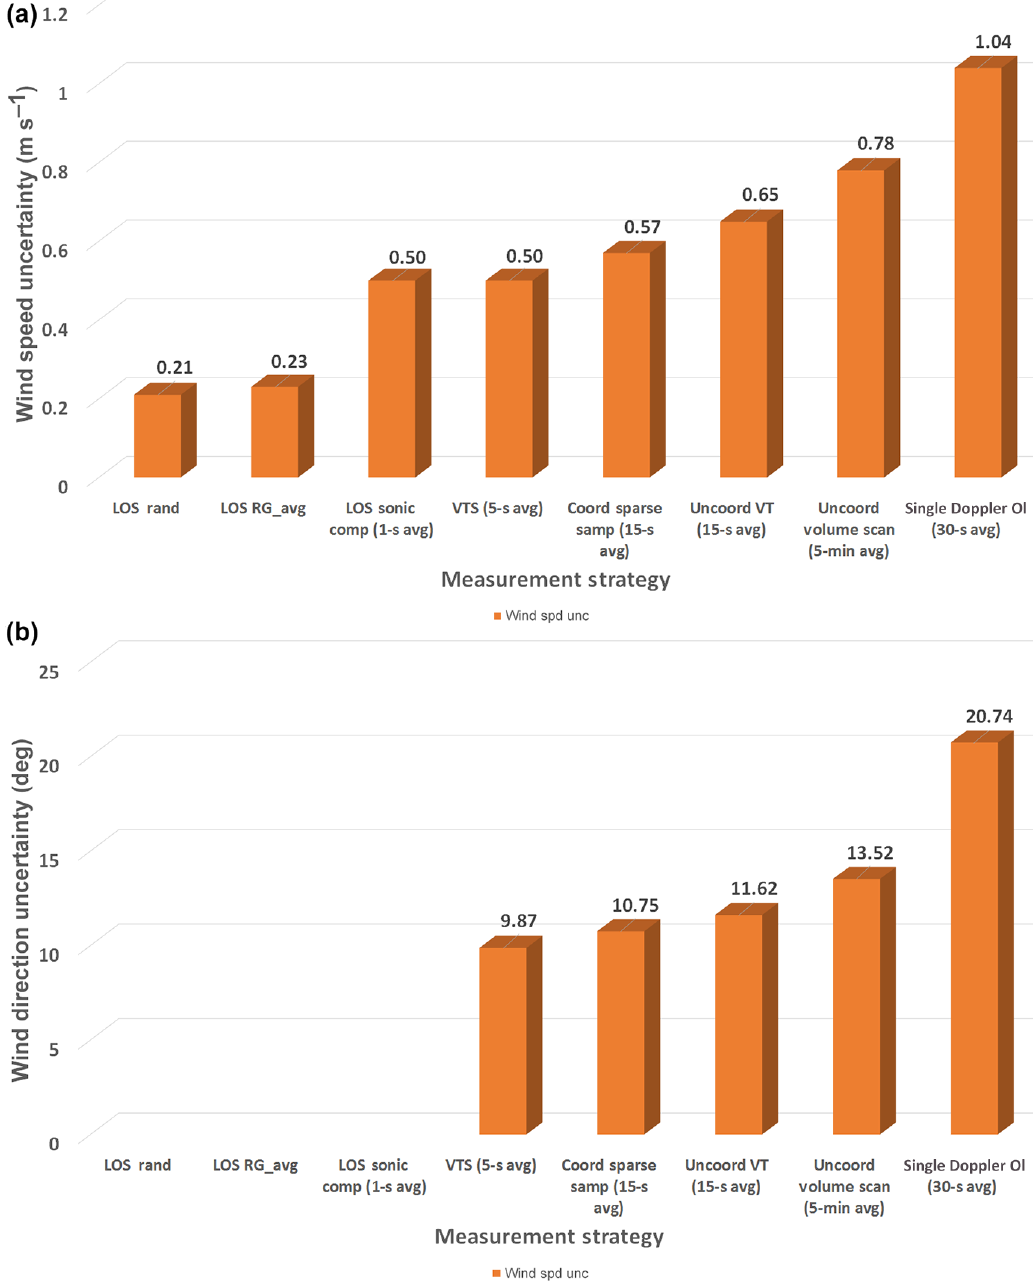
Figure 14. Measurement uncertainties for (a) horizontal wind speed and (b) horizontal wind direction estimated for the different measurement strategies